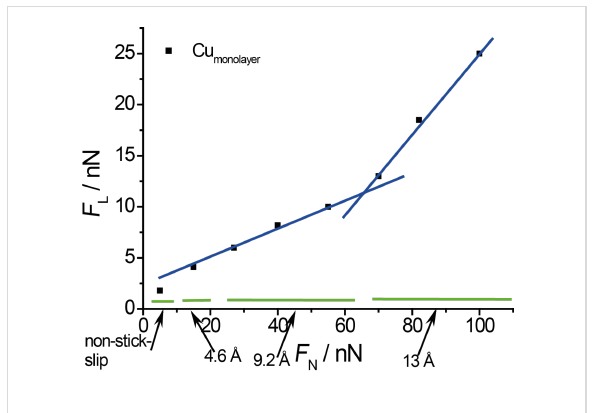
Figure 9: Friction force as a function of normal load (data, e.g., from Figure 8a).